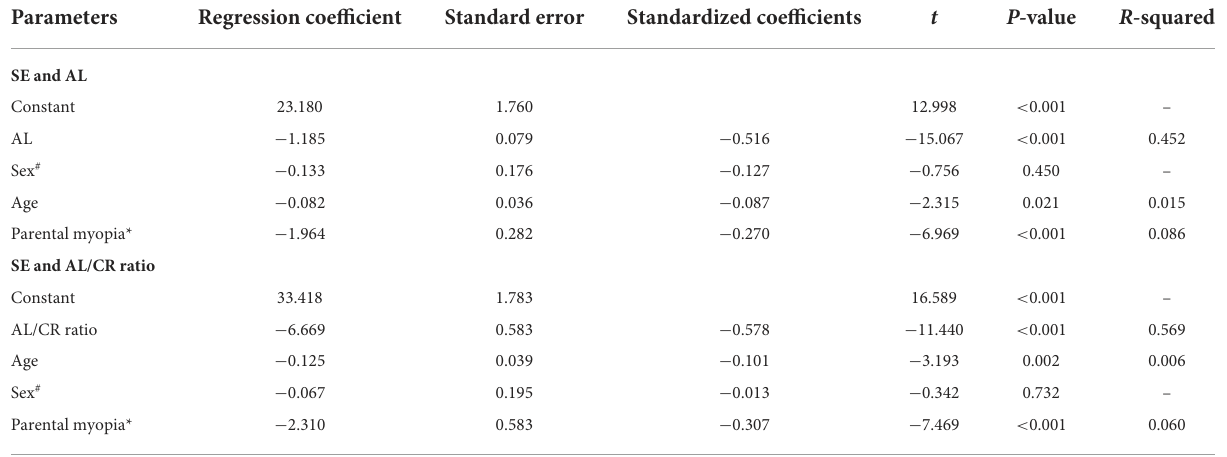
TABLE 4 Multiple linear regression analysis of SE, AL, AL/CR ratio.